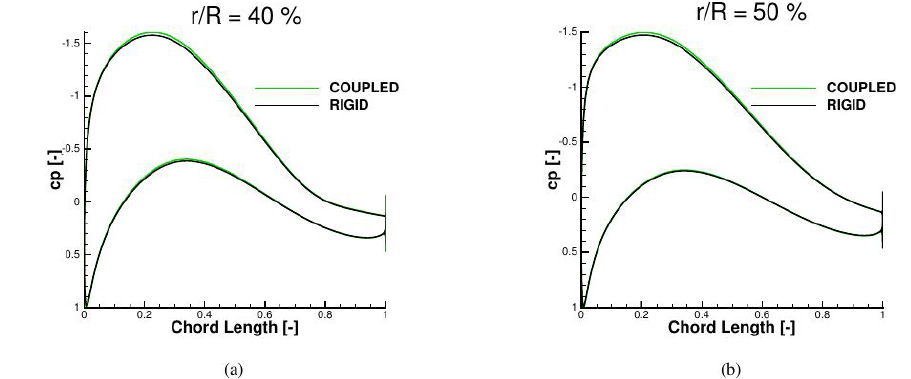
Figure 12. Pressure distributions for FMU rigid and coupled in comparison calculated with CFD at 6.1ms − 1 .